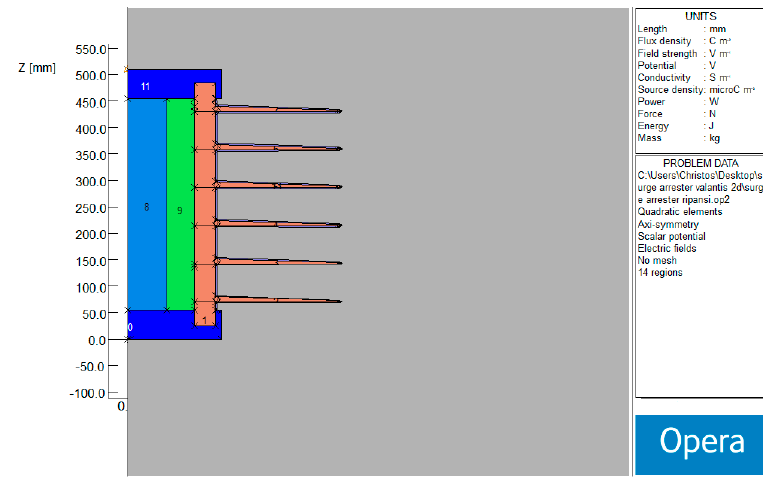
Figure 9. 2D PC Opera model of the arrester under study in the case of pollution on the surface of the external insulation.